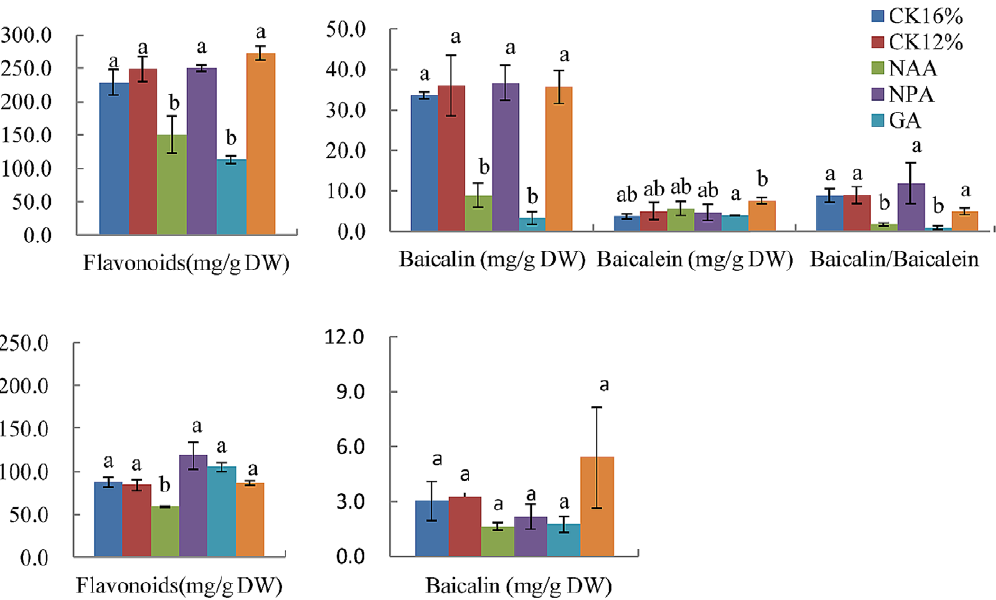
Figure 5. Effects of plant growth regulators on flavonoid levels in S.baicalensis . Total flavonoids, baicalin, baicalein, and the ratio of baicalin to baicalein in roots (A, B) and leaves (C, D) of S. baicalensis . Vertical bars indicate the standard deviation of three biological replicates. Asterisks indicate a significant difference at the P , 0.05 level.